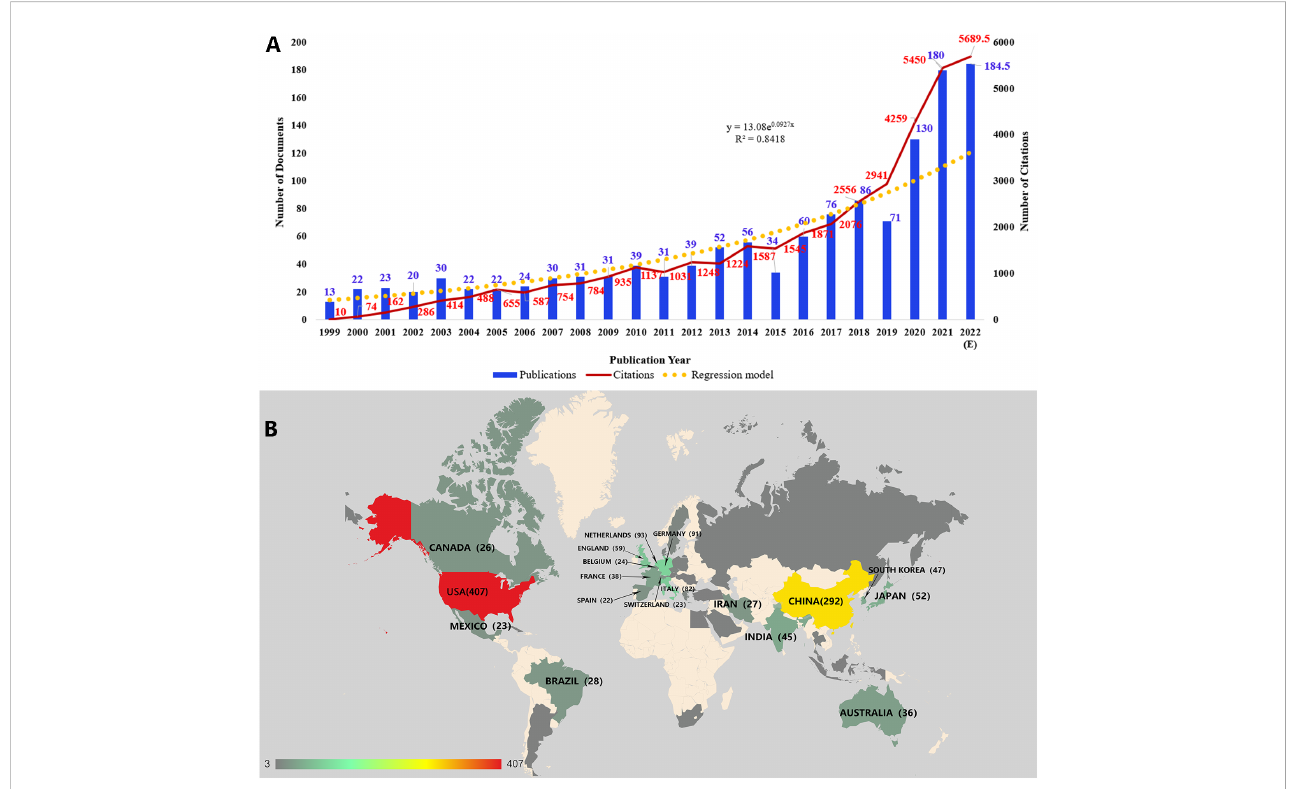
FIGURE 1 (A) The distribution of publications and citations by year. The regression formula is y = 13.08e0.0927x, R2 = 0.8418. Since the publications in our current study did not cover all publications in 2022, the expected number of publications in 2022 was calculated. (B) The geographical visualization of publications for immunotherapy in cervical cancer.